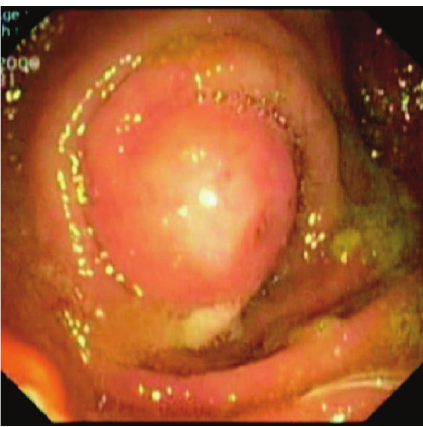
Figure 1: Bulging polypoid lesion into the cecal lumen.